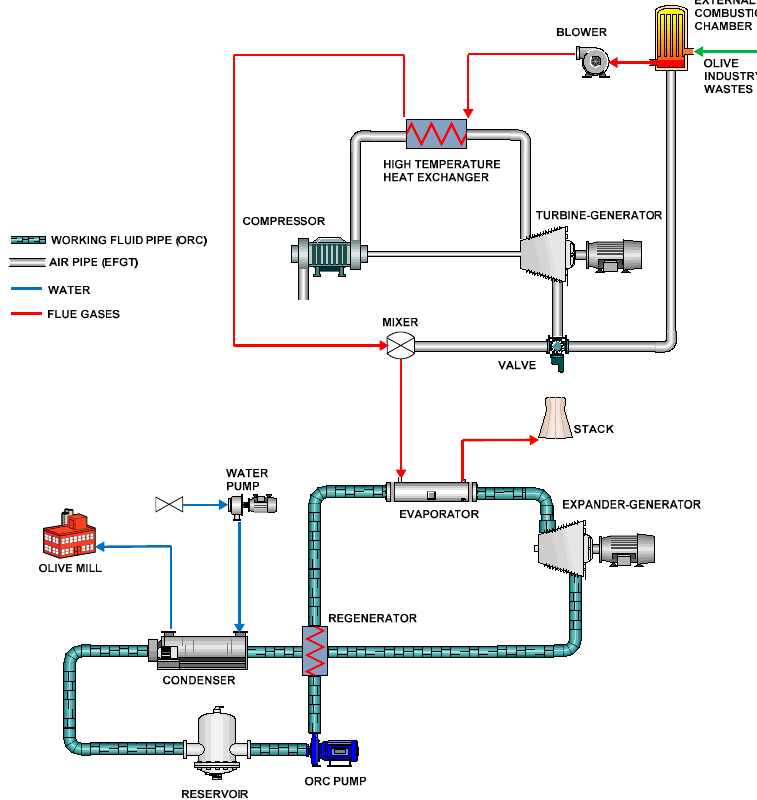
Figure 3. Layout of the hybrid EFGT-ORC power plant.